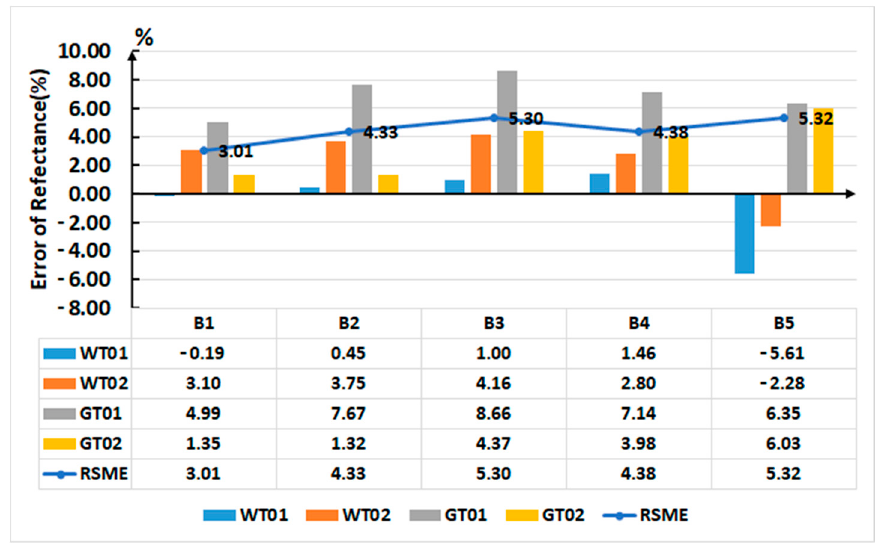
Figure 23. Error of reflectance of targets in five spectral images corrected by the manufacturer’s method.